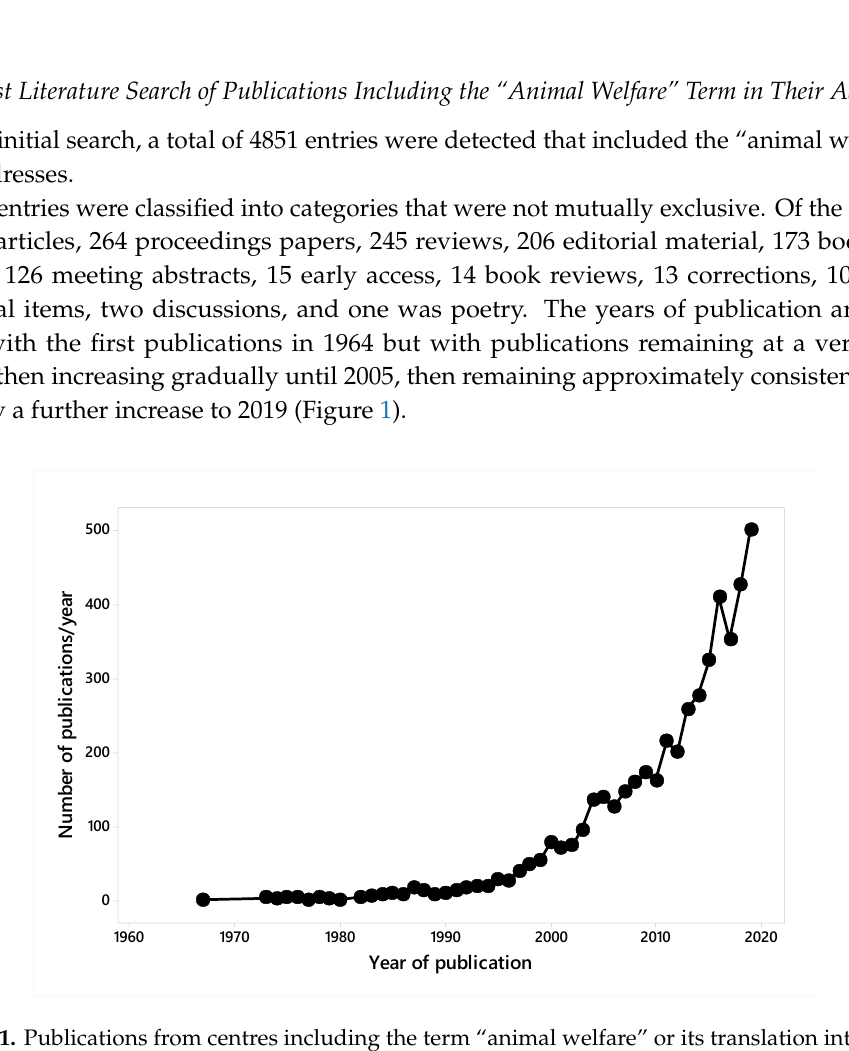
Figure 1. Publications from centres including the term “animal welfare” or its translation into major languages between 1995 and